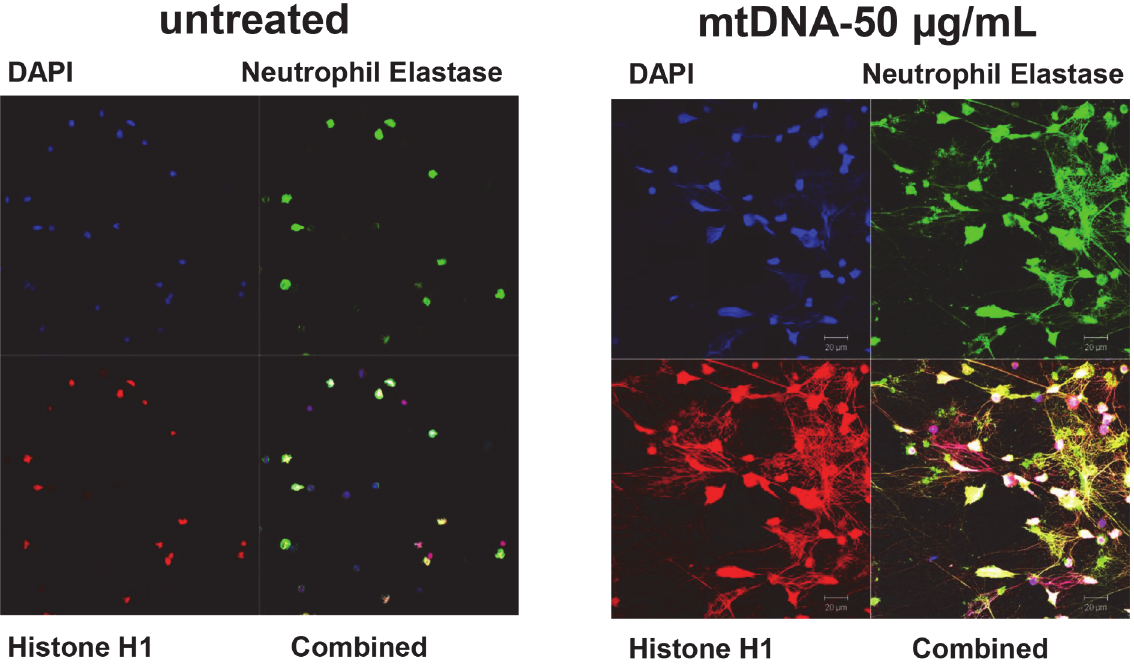
Fig 1. MtDNA induces NET formation. Freshly isolated PMN from young volunteers were attached to coverslips for 1 h and treated with either medium (untreated) or with purified mtDNA (50 μ g/mL) for 4 h. NET formation was detected as described in Materials and Methods. Experiments were repeated more than three times. Magnification